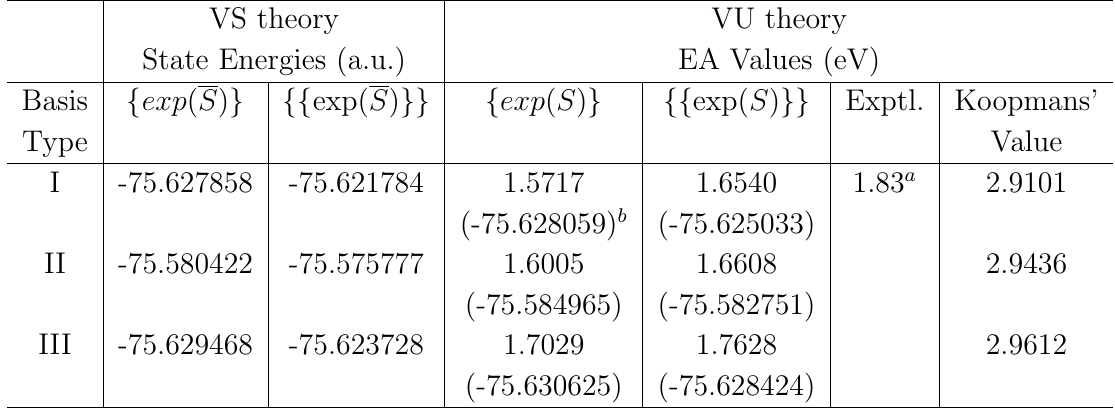
Table 1: Electron affinity study of OH radical, using different basis